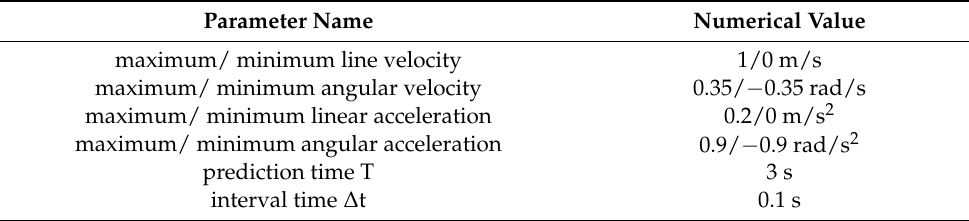
Table 1. Speed Parameters of DW.